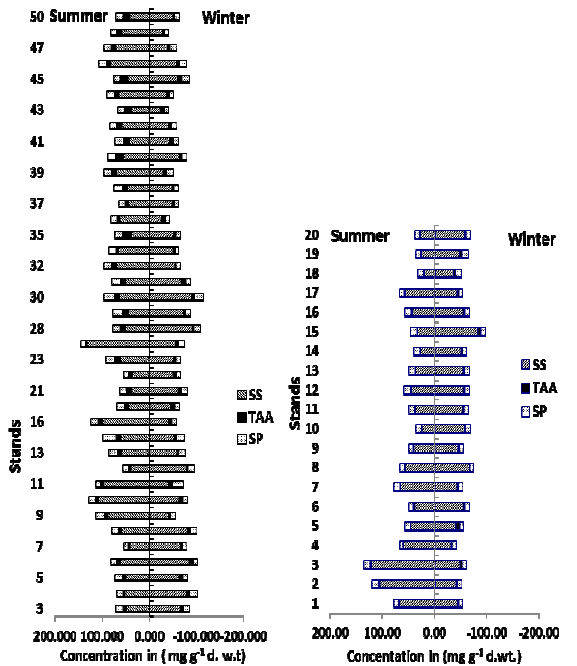
Fig. 7. Concentrations of soluble sugars (SS), soluble proteins (SP), and total free amino acids (TAA) expressed as mg g -1 d.wt. in Zilla spinosa and Leptadenia pyrotechnica plants growing in Wadi El-Assiuty during summer and winter